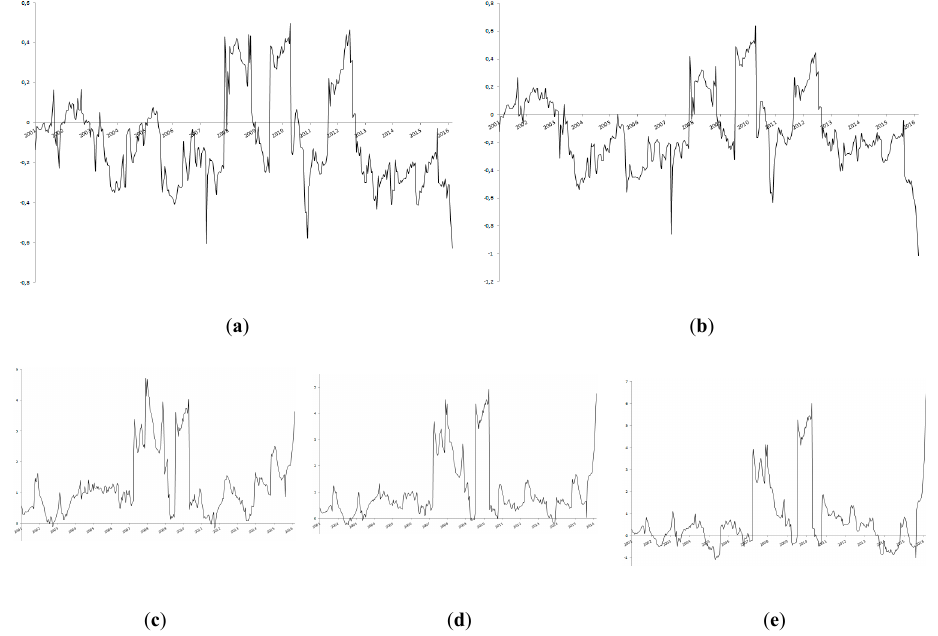
𝜆 (cid:2869),(cid:2870) ; ( b ) 𝜆 (cid:2870),(cid:2869) ; ( c ) 𝜅 (cid:2869),(cid:2871) ; ( d ) 𝜅 (cid:2870),(cid:2870) ;